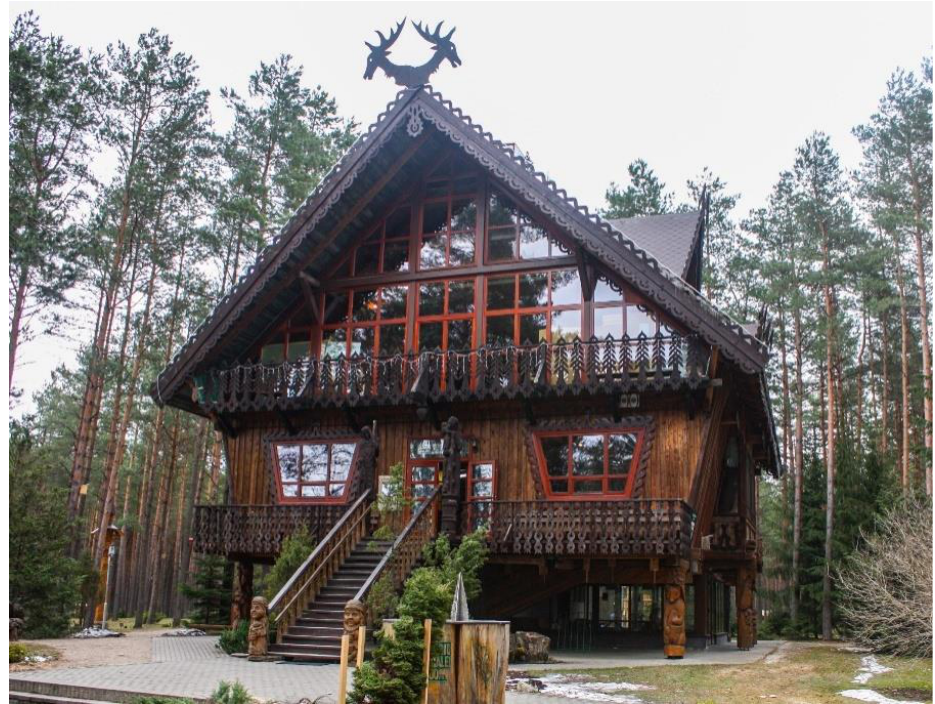
Figure 13. Museum “Girių aidas” in Druskininkai, designed by Algirdas Valavičius in 1971. Photo by A. Gabrėnas.